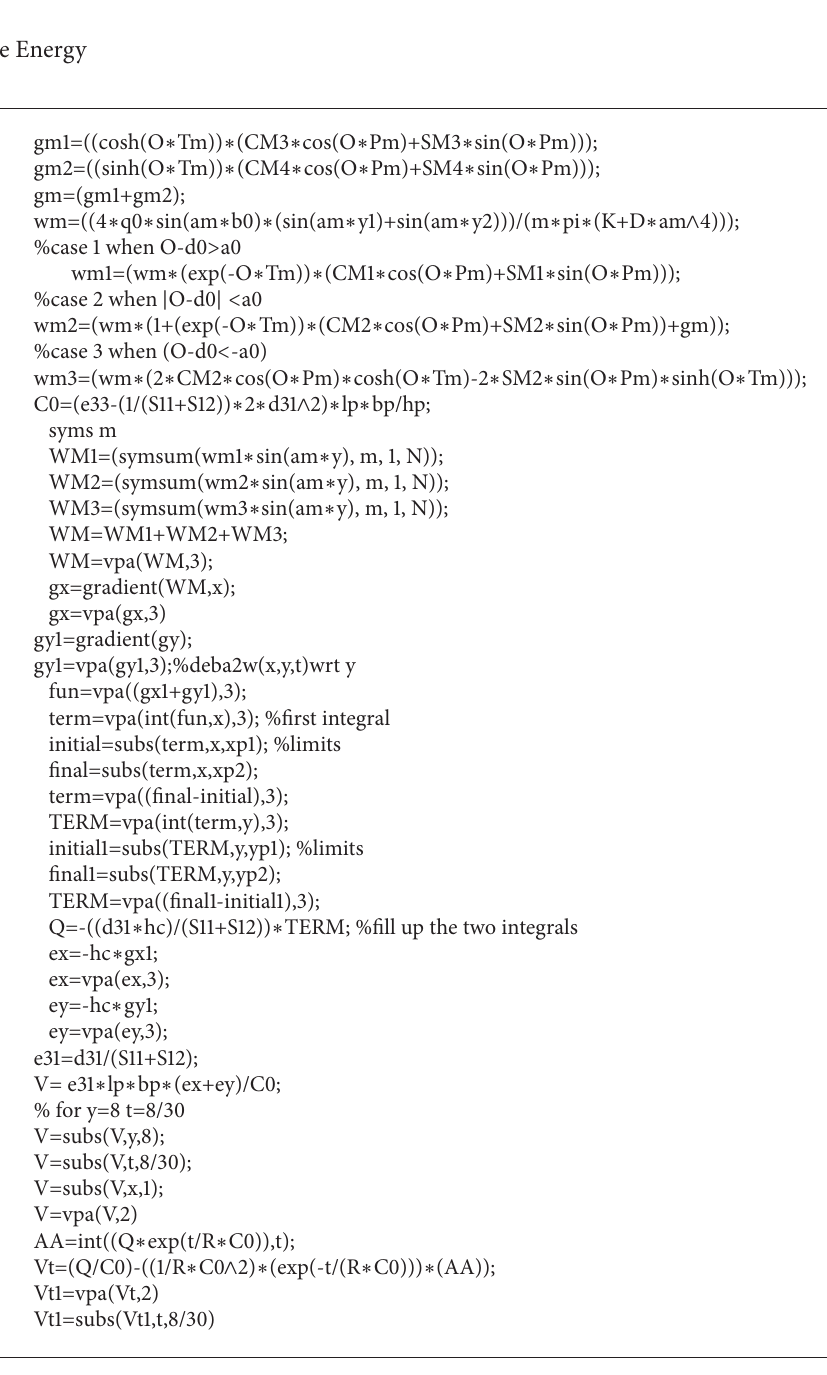
Algorithm 1: MATLAB